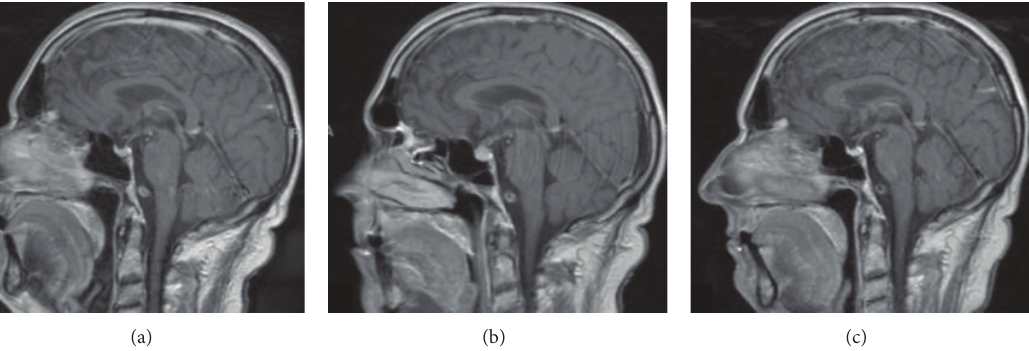
Figure 7: Magnetic resonance images of the brain demonstrating ipilimumab-associated hypophysitis. (a) Prior to therapy, with no metastatic disease indicated. (b) Diffuse enlargement of the pituitary gland following reports of cognitive impairment during therapy. (c) Resolution of hypophysitis after discontinuation of ipilimumab and initiation of hormone-replacement therapy [14]; reproduced with permission from Carpenter et al. 2009 [14].